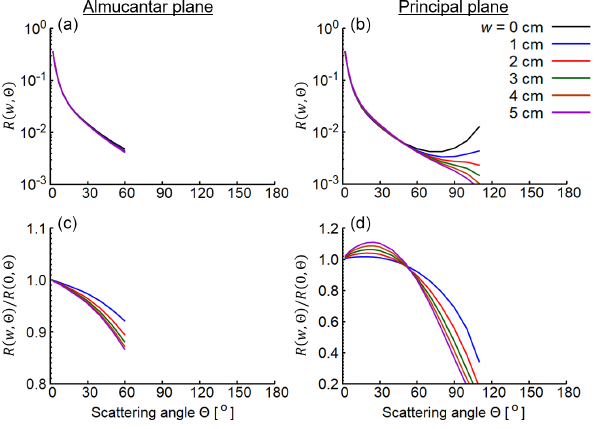
water vapor channel are interpolated from those at aerosol channels. PWV is retrieved from the normalized angular